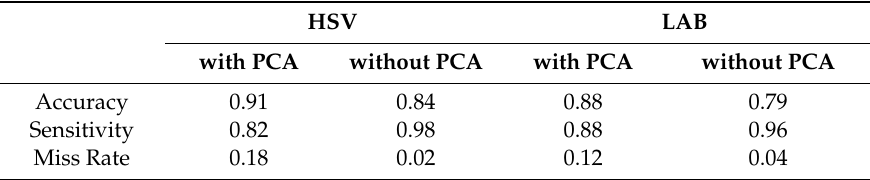
Table 1. Isolation